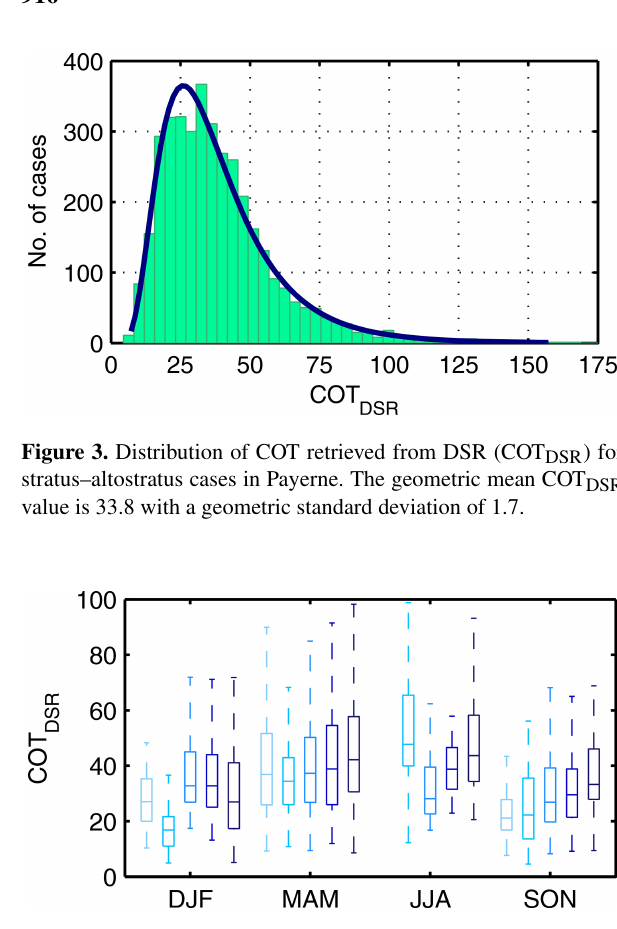
Figure 4. Distribution of the COT DSR values per season (DJF: win- ter, MAM: spring, JJA: summer, SON: autumn) and years (light to dark blue: 2013 to 2017) of St–As in Payerne. The boxplots show the median, the interquartile range and the 95% intervals of the COT DSR values. No data in JJA 2013.